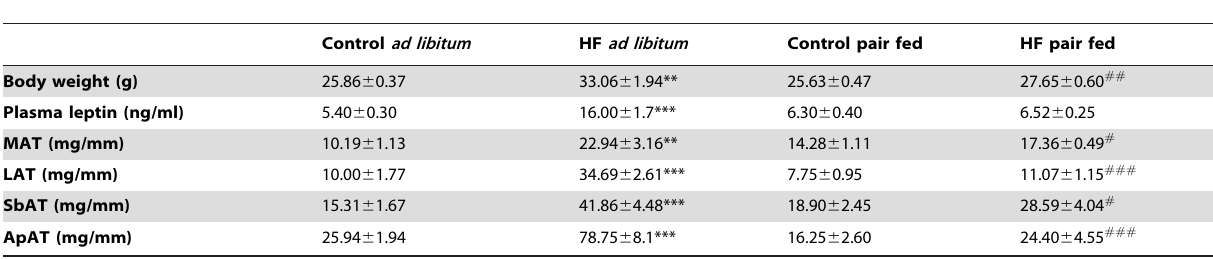
Table 1. Body weight, plasma leptin and weight of adipose tissues.